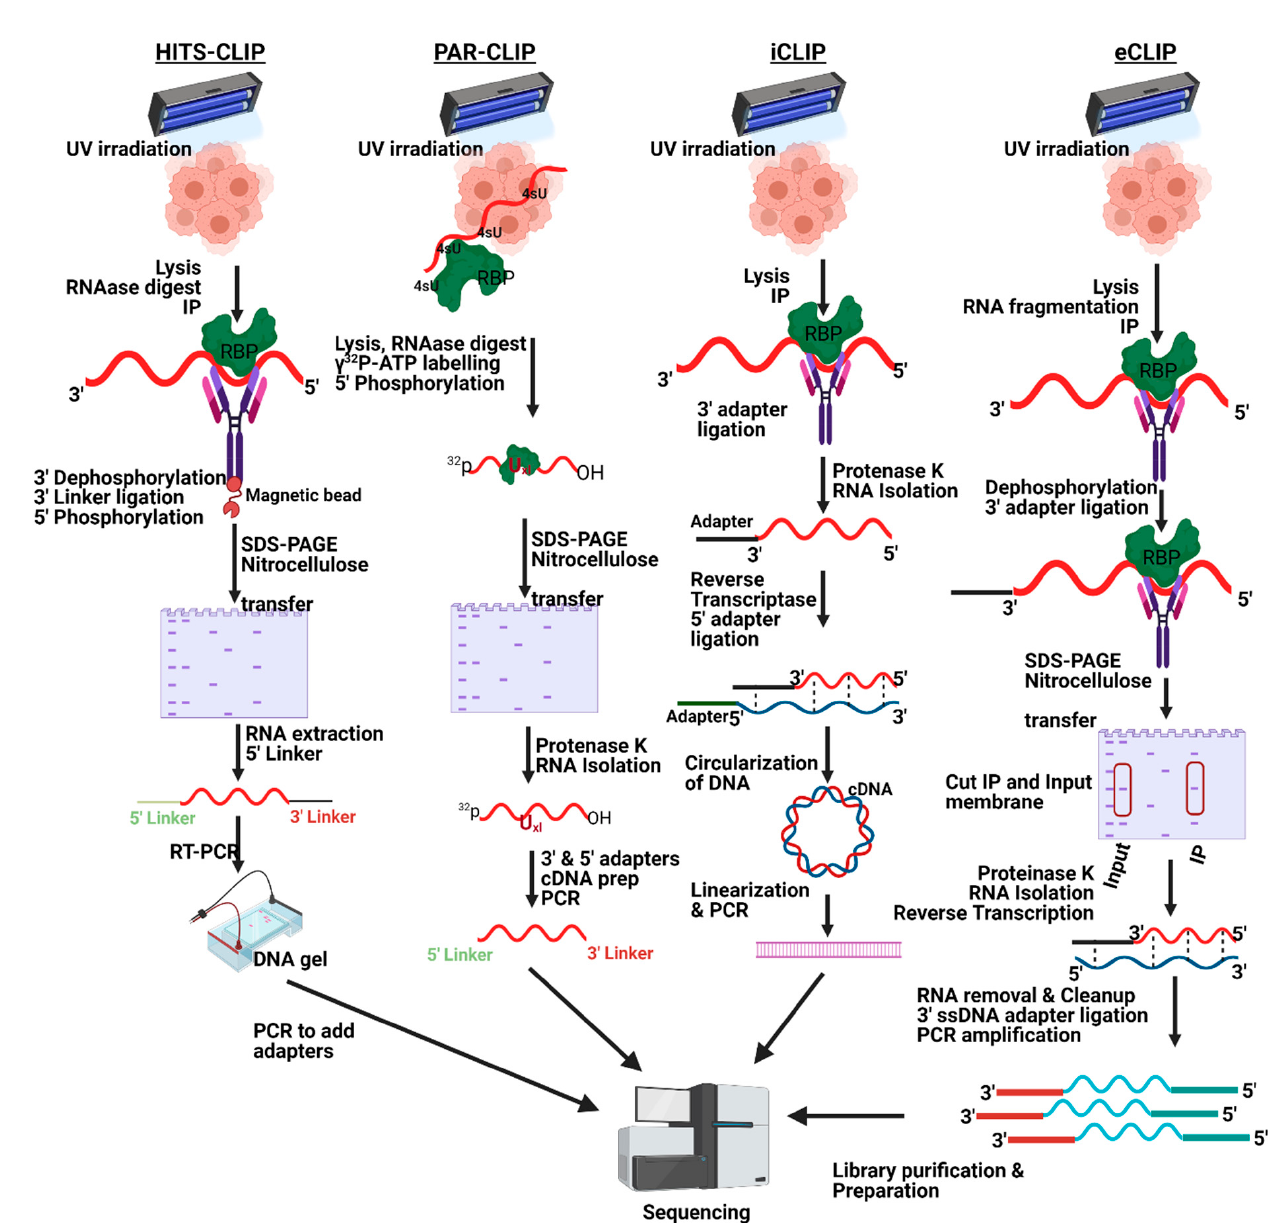
Figure 2. Comparison between the crosslinking and immunoprecipitation (CLIP) protocols.